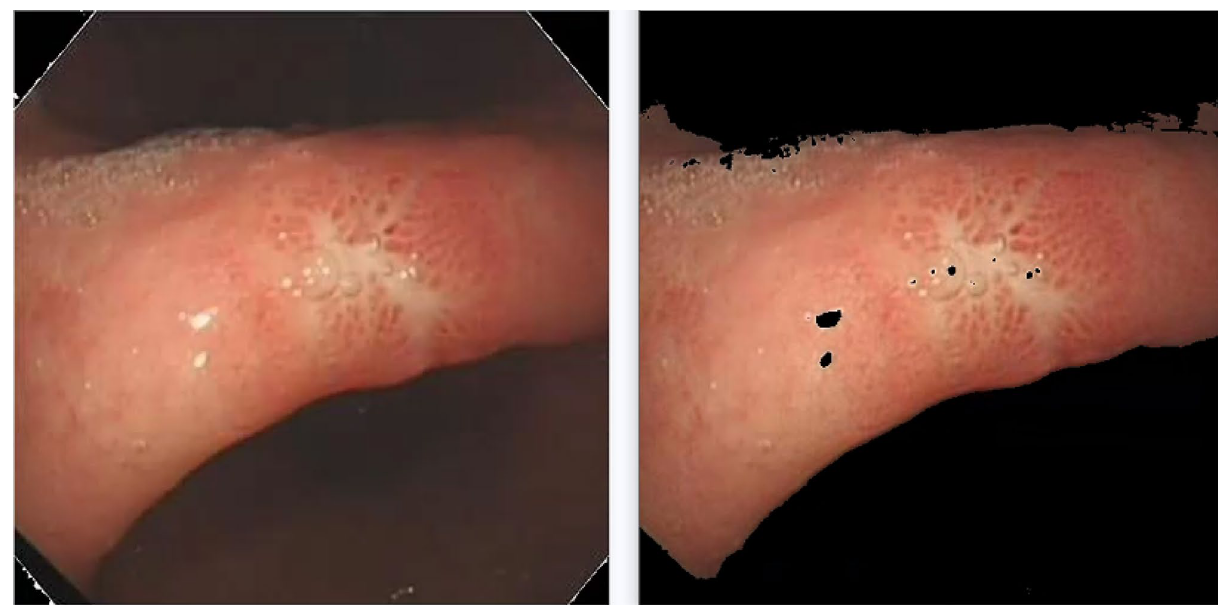
Figure 2. The original image (left) and the pre-processed (right)